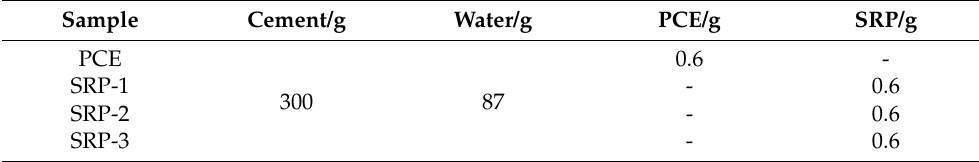
Table 3. Mix proportions of cement